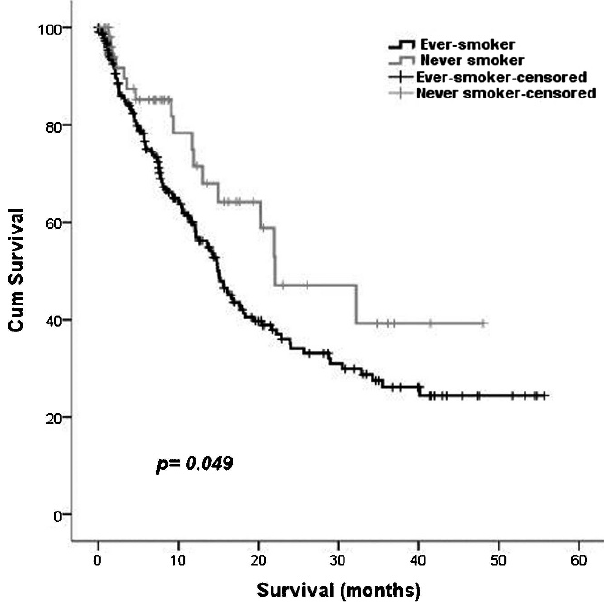
Figure 1 - Sixty-month survival Kaplan-Meier curve for NSCLC patients grouped according to smoking